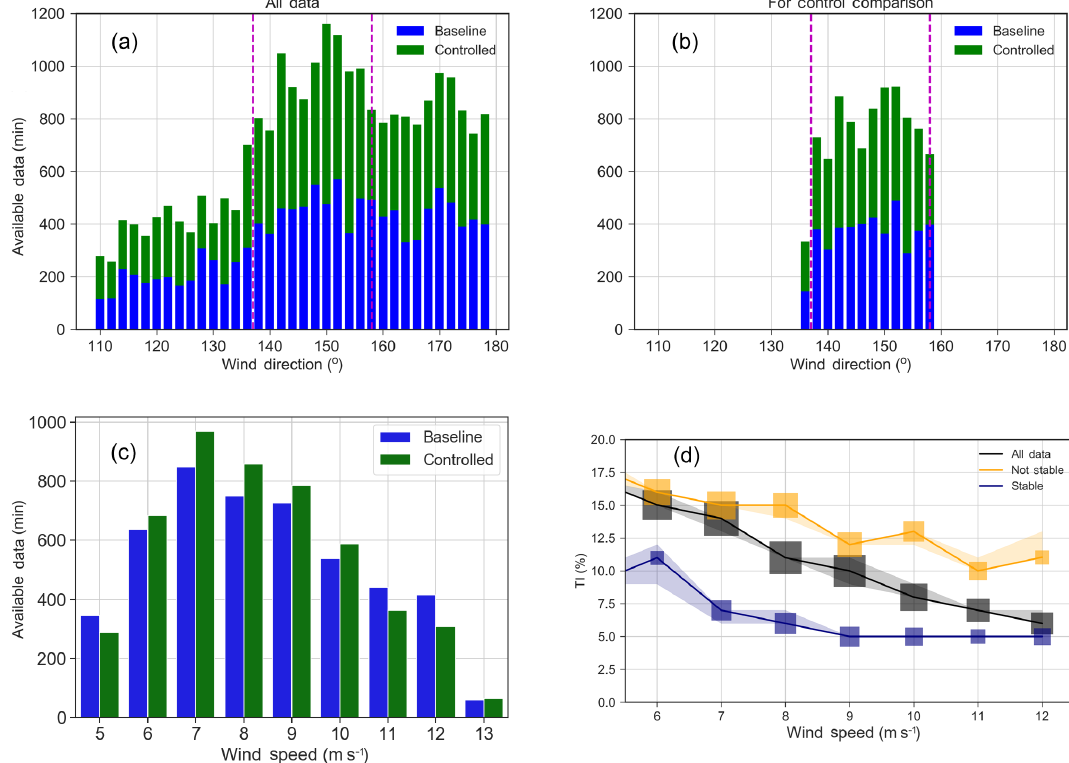
Figure 7. Atmospheric conditions observed by the sodar at hub height over the duration of the test